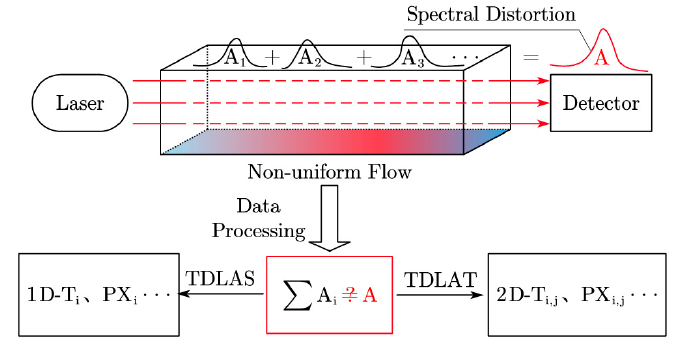
Figure 1. Schematic of TDLAS measurement in a nonuniform flow field.